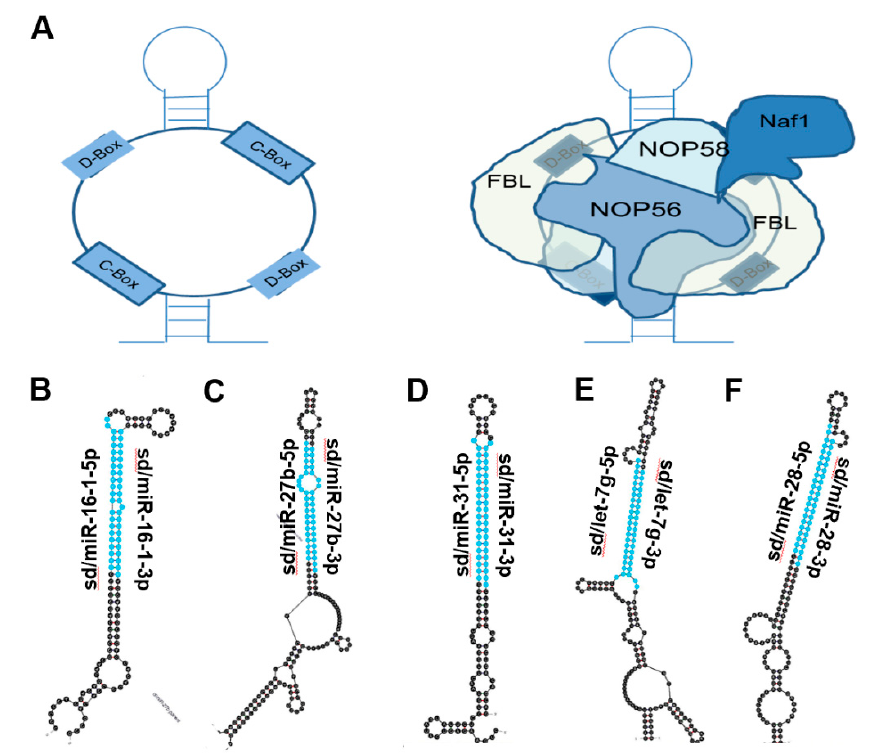
Figure 2. miRNAs derived from C/D Box snoRNA-like transcripts that bind fibrillarin. ( A ) Cartoon illustration of C/D Box snoRNA ( left ) and schematic of C/D Box snoRNA bound to fibrillarin complex, giving rise to snoRNP ( right ). Fibrillarin complex consists of NOP56, NOP58, NAF1 and Fibrillarin [18]. ( B – F ) Most thermodynamically stable secondary structures of C/D Box snoRNA-like transcripts described to bind fibrillarin complex [19] were obtained from mfold [20]. Mature miRNA sequences embedded in these transcripts are highlighted in blue. ( B ) miR16-1 (ENSG00000208006) is downregulated in chronic lymphocytic leukemia, gastric, NSCLC, Osteosarcoma, and breast cancer and is embedded within a C/D Box snoRNA-like transcript (GRCh38: chr 13:50048958-50049077:-1) known to bind fibrillarin [1,21–24]. ( C ) miR-27b (ENSG00000207864) is downregulated in prostate, lung, and bladder cancer and is located within a C/D Box snoRNA-like transcript (GRCh38: chr 9:95085436-95085592:1) known to bind fibrillarin [25–27]. ( D ) miR-31 (ENSG00000199177) is upreg- ulated in colorectal, HNSCC, and lung cancer but is downregulated in glioblastoma, melanoma, and prostate cancer. miR31 is also located within a C/D Box snoRNA-like transcript (GRCh38: